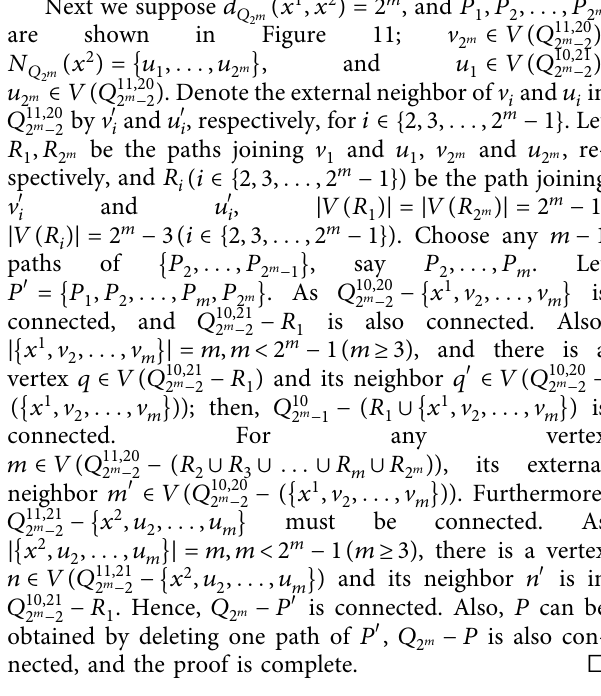
Figure 10: Te illustration of d